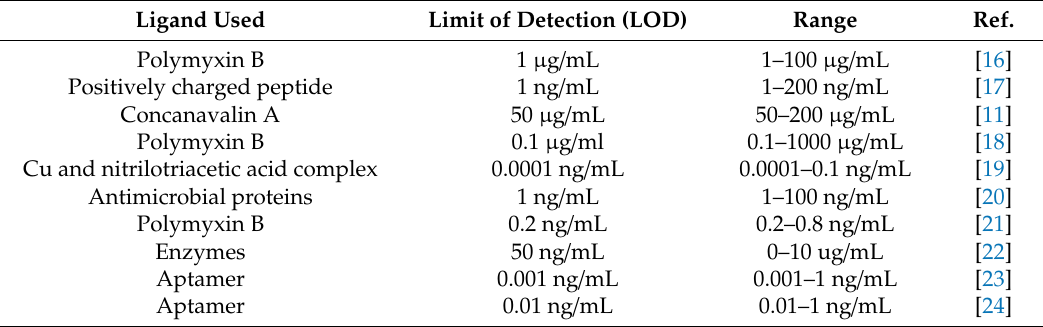
Table 1. Summary of ligands and detection in various reported electrochemical LPS